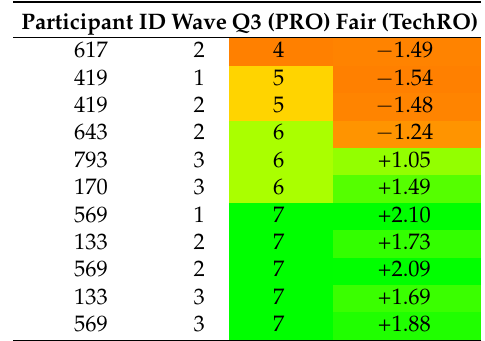
Table 16. Raw data for a 28-day interval and a 21-day leeway that yielded the highest correlation (0.92).